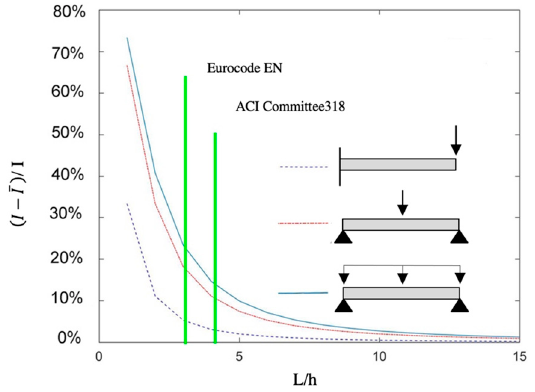
Figure 9. Percentage error between the estimated inertia using the OM method 𝐼 ̅ with the actual one I for three beams in terms of the slenderness ( L / h ratio).